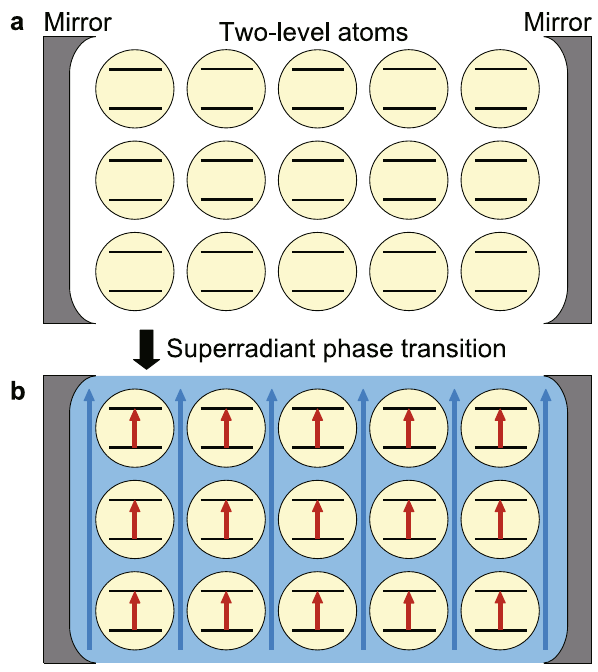
Figure 1. Sketches of system under investigation (Dicke model) and superradiant phase transition. The system consists of two-level atoms (yellow circles) collectively coupled with a single photonic field in a cavity composed with two mirrors. ( a ) In the normal phase, the expectation values of the photonic field (transverse electromagnetic field) and atomic field (electromagnetic polarization) are zero. ( b ) In the superradiant phase, the photonic and atomic fields (blue and red arrows, respectively, and order parameters) get static non-zero values